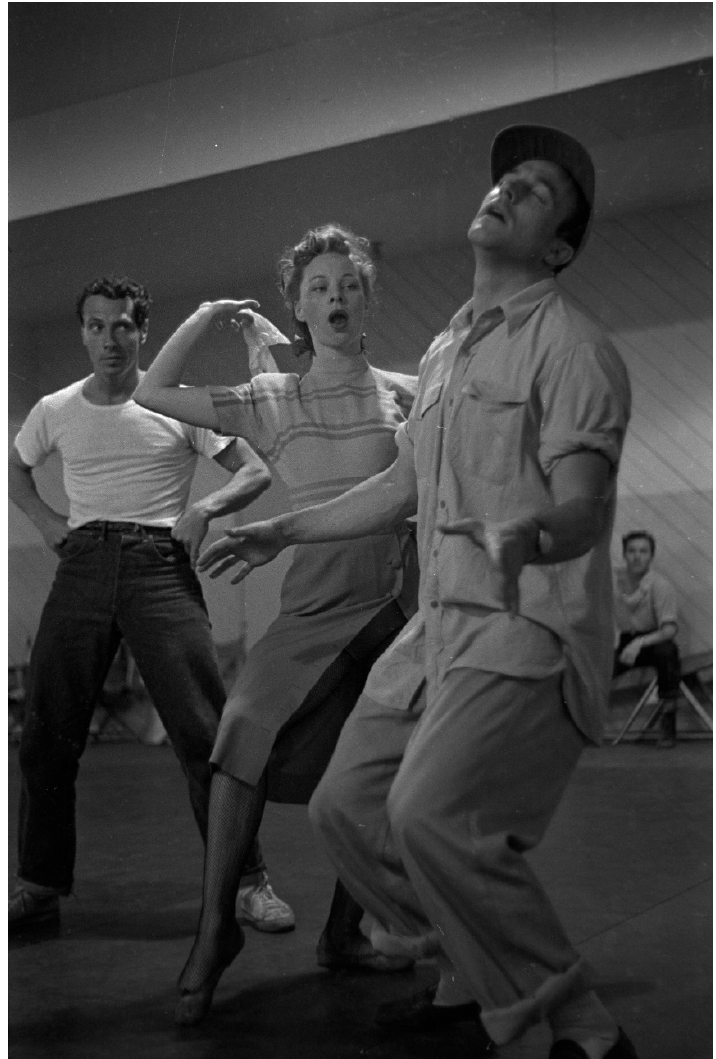
Figure 4. Alex Romero, Carol Haney, and Gene Kelly rehearsing “A Day in New York” on the set of “On the Town.” Jon Brenneis photograph archive, BANC PIC 2002.171, The Bancroft Library, University of California, Berkeley. The photo was taken by Jon Brenneis on assignment for LIFE Magazine in July 1949, and appeared in the 26 December 1949 issue. [Jon Brenneis]/[The LIFE Images Collection] via Getty Images.